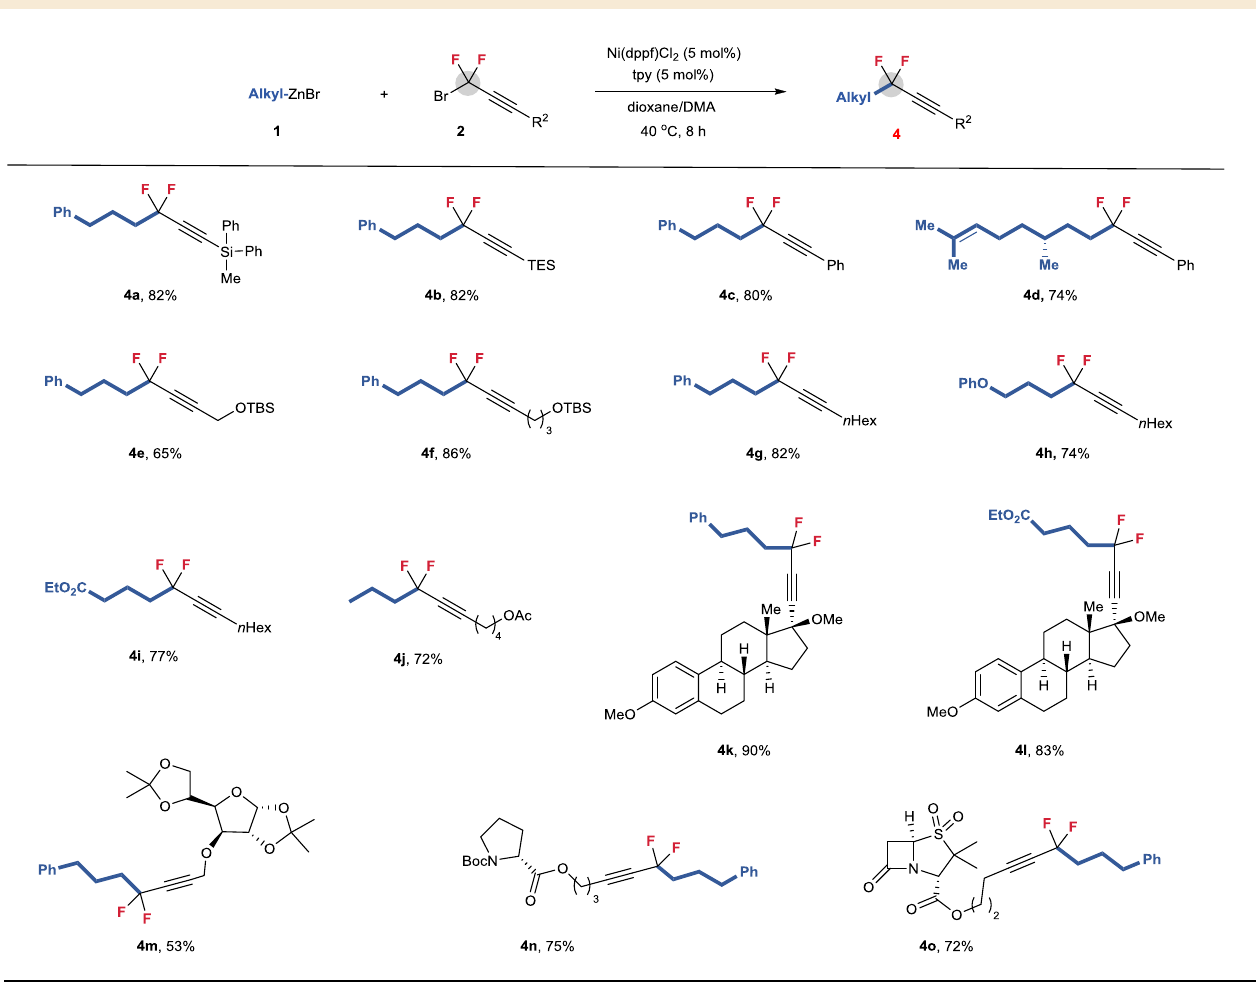
Table 3 Ni-catalyzed cross-coupling of 1 with 2